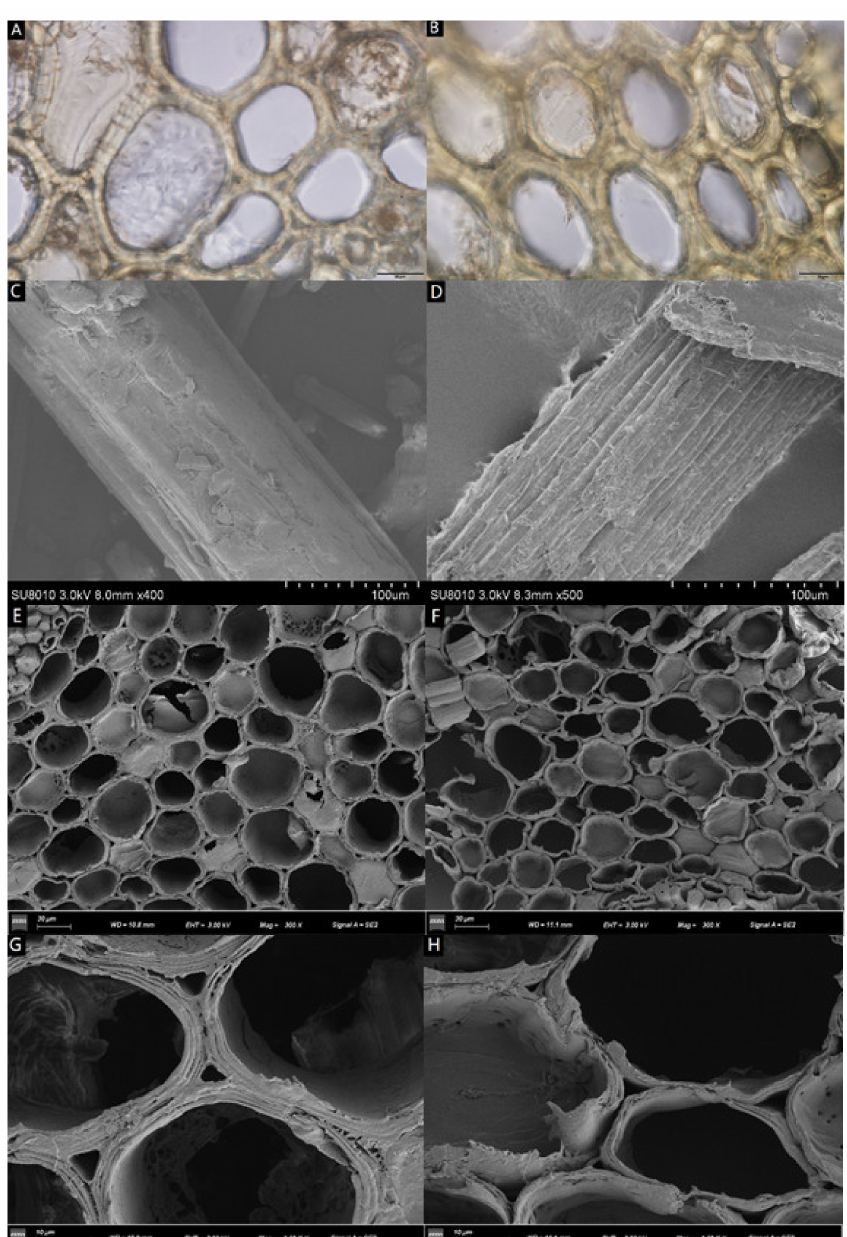
Figure 2. SEM images of bamboo biomass before and after pretreatment magnification ranging from 10 to 100 µ m. ( A , E , G ) Untreated bamboo slices, ( C ) untreated bamboo powder; ( B , F , H ) 4%NaOH 20%EtOH treated bamboo slices, ( D ) cellulosic sample after pretreatment with 20% NaOH in 20%